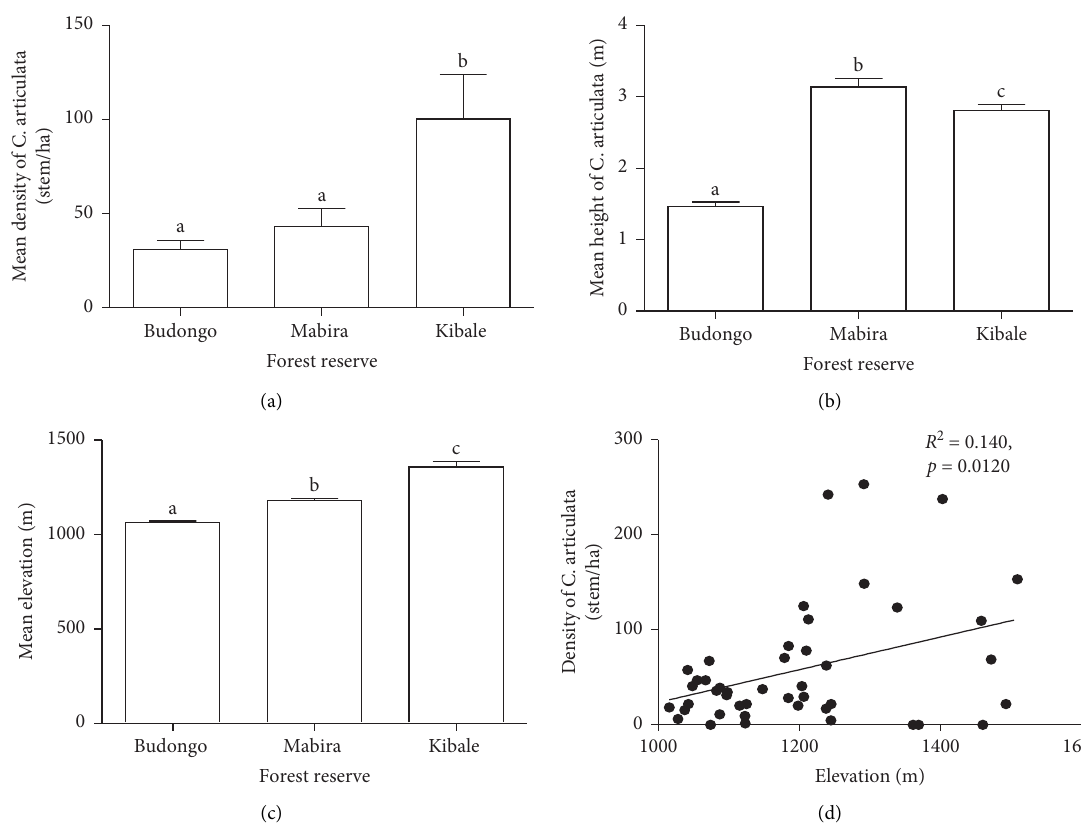
Figure 5: (a) Variation in density of C. articulata in three forests of Uganda. (b) Variation in height of C. articulata . (c) Altitudinal variation in site of occurrence of C. articulata in three forests of Uganda (habitat of C. articulata ). Error bars represent standard error, and column bars with different lowercase letters indicate significant difference at p < 0 . 05 based on Tukey’s multiple comparison test. (d) Relationship between density of C. articulata and